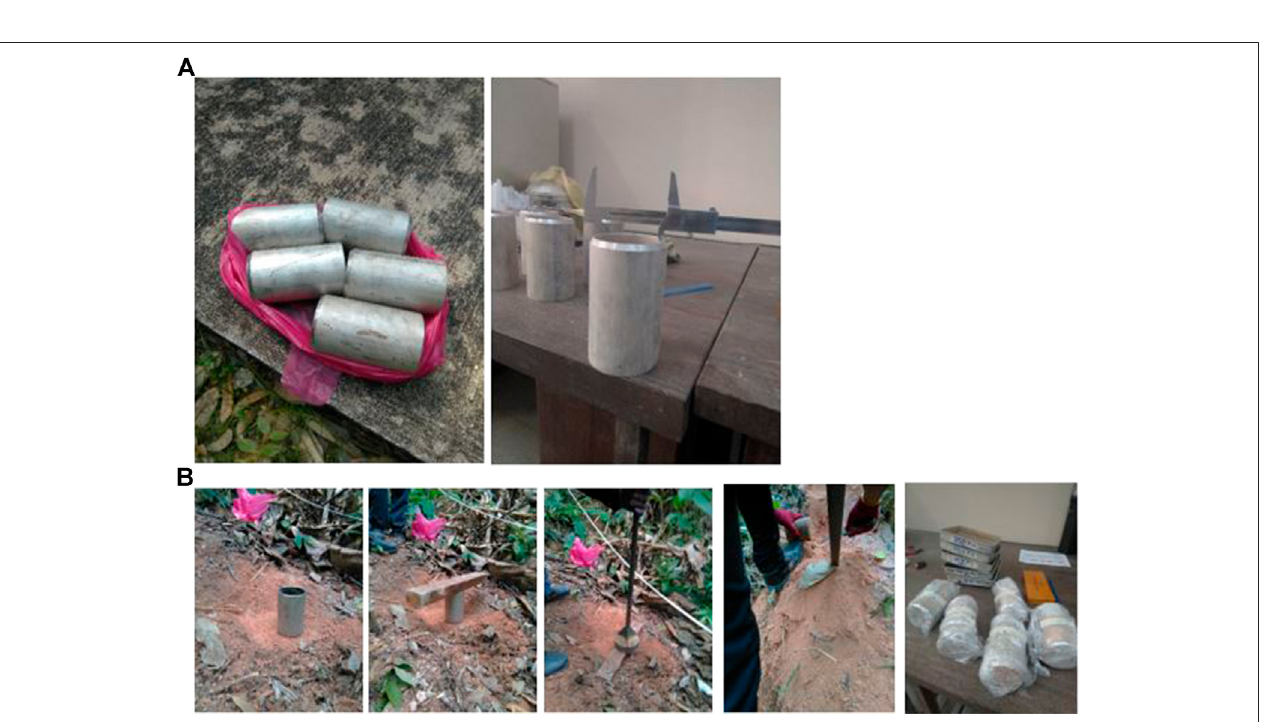
FIGURE 3 | A mechanical shaker and oven-dried soil